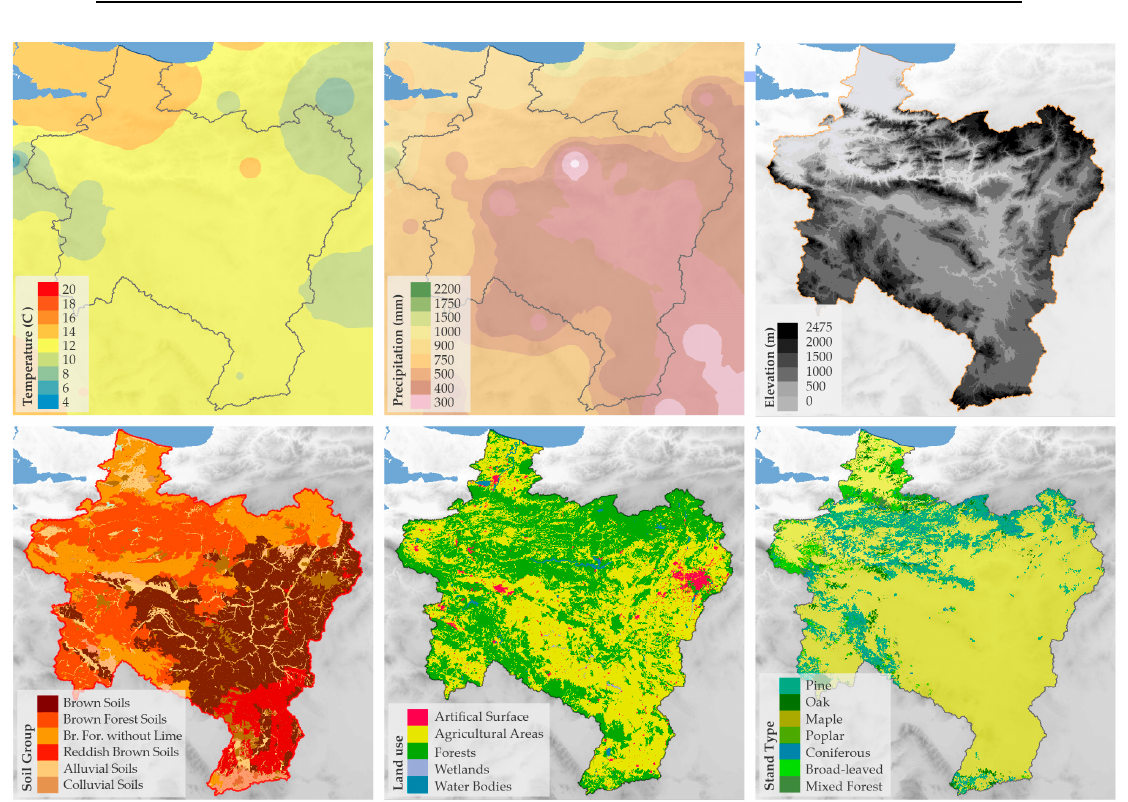
Figure 3. Maps of the study area; temperature, precipitation, elevation, soil group, land use, and stand type. DEM (Digital elevation map) derived from SRTM (Shuttle Radar Topography Mission) with a resolution of 1 arc-second (30 m × 30 m) data were used to delineate the drainage areas with ArcSWAT [81,82] software (version 2012.10-3.18, Texas A&M AgriLife Research, College Station, TX, USA), and the basin was divided into 379 sub-basins.